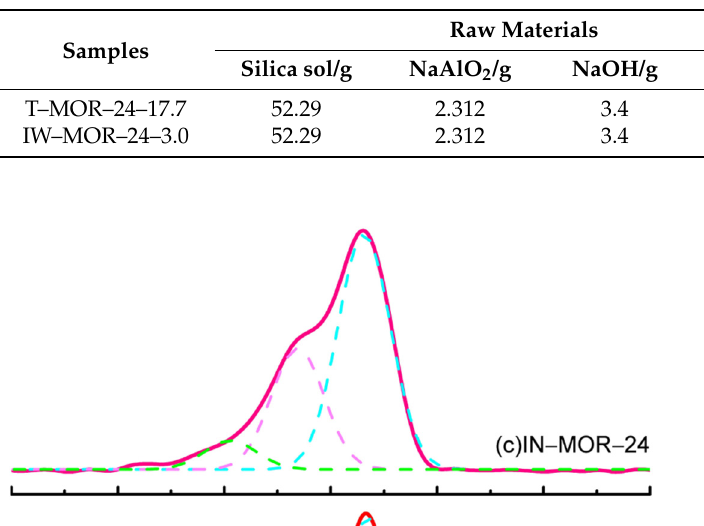
Table 4. The yield of T–MOR–24 and IW–MOR–24 samples.